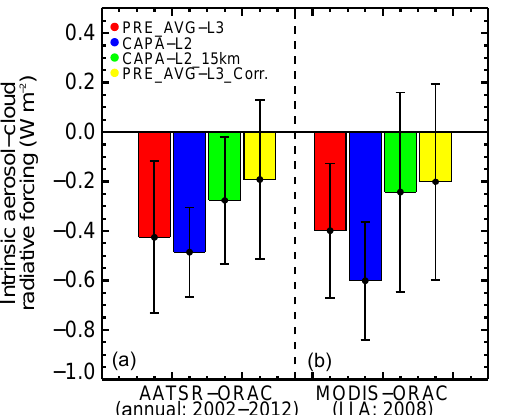
Figure 7. Estimated intrinsic aerosol–cloud radiative forcing by global marine warm clouds derived using top of atmosphere short- wave fluxes from AATSR-ORAC (a) and MODIS–ORAC (b) . Esti- mates are provided using the pre-average standard level-3 products (PRE_AVG-L3 composite; red), and pre-average corrected level-3 products in which the nearest aerosol is located at least 15km from any other cloud (PRE_AVG-L3_Corr.; yellow), cloud pairs using the nearest high-resolution aerosol retrieval (CAPA-L2; blue) and cloud pairs using the nearest high-resolution aerosol retrieval that is at least 15km away from any other cloud (CAPA-L2_15km; green). Error bars are calculated on the basis of the standard error of the re- gression slope.